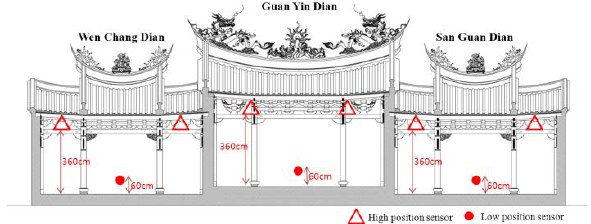
Figure7 、 Sensors of height position in Beigang Chao-Tian